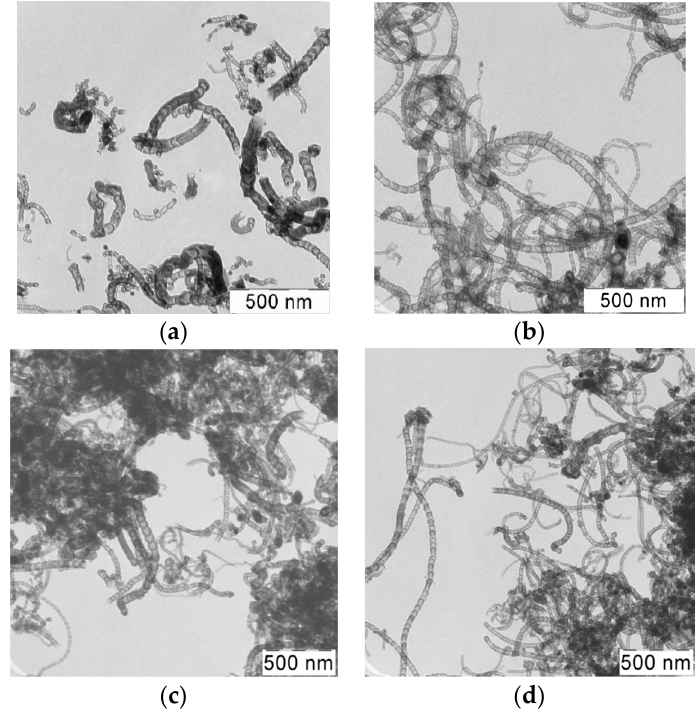
Figure 5. ( a , b ) TEM—images of N-CNT obtained using a gas mixture of C 3 H 8 /NH 3 (50/50%); ( c ) 25/75%; ( d ) 75/25%; at a temperature of 650 ° С .